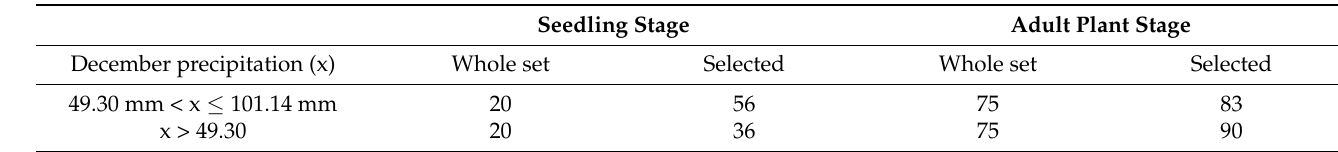
Table 5. Frequency of resistant landraces (%) to yellow rust (DS ≤ 10) in the whole set and in the selected landraces at seedling and adult stages with the threshold values established for Decem- ber precipitation. Seedling Stage Adult Plant Stage Whole set Selected Whole